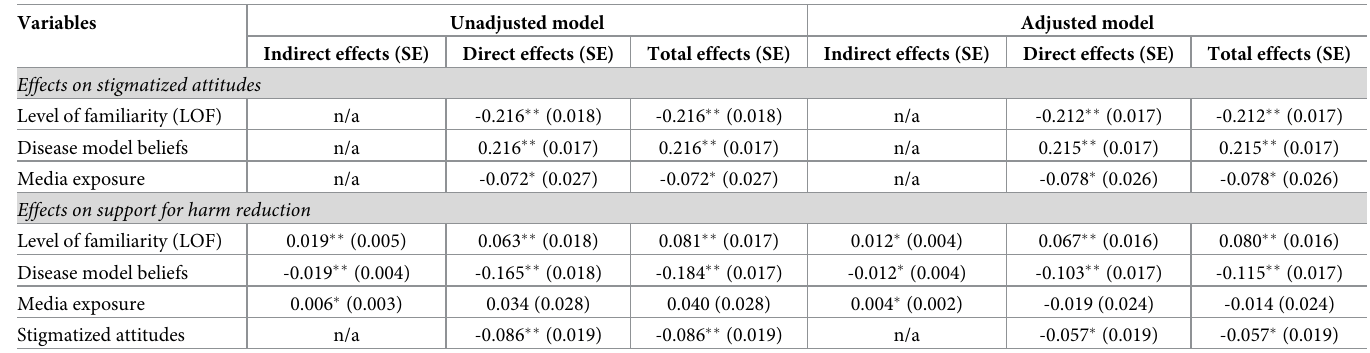
Table 3. Indirect, direct, and total effects for the unadjusted and adjusted